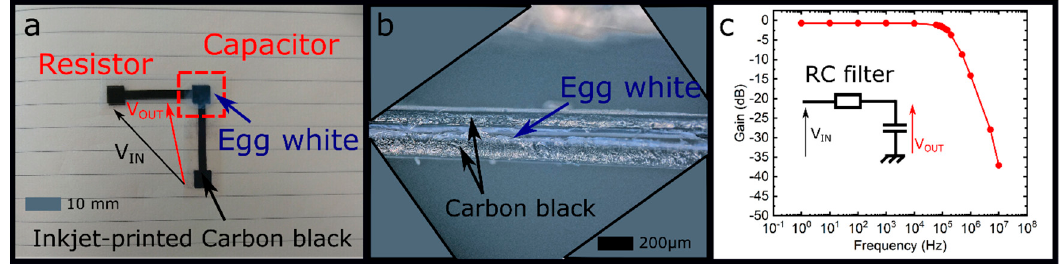
Figure 3. RC filter. ( a ) Optical image of the device composed of a resistor and a capacitor in series. The resistor and the capacitor’s electrodes are made of a printed carbon. The egg white, used as insulator, is screen printed. ( b ) An optical microscope image of the capacitor stack, showing the PET substrate, the CB, and the insulating layers. ( c ) A schematic diagram of the RC filter and the obtained magnitude Bode diagram.